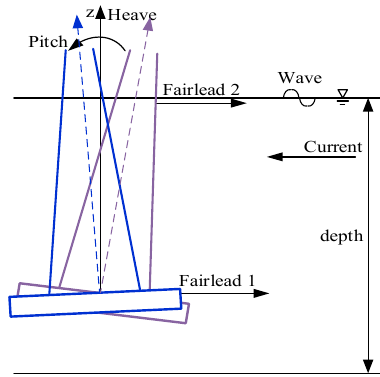
Figure 8. Schematic view of the pitch and heave motion directions, the loading environments and the fairlead positions.